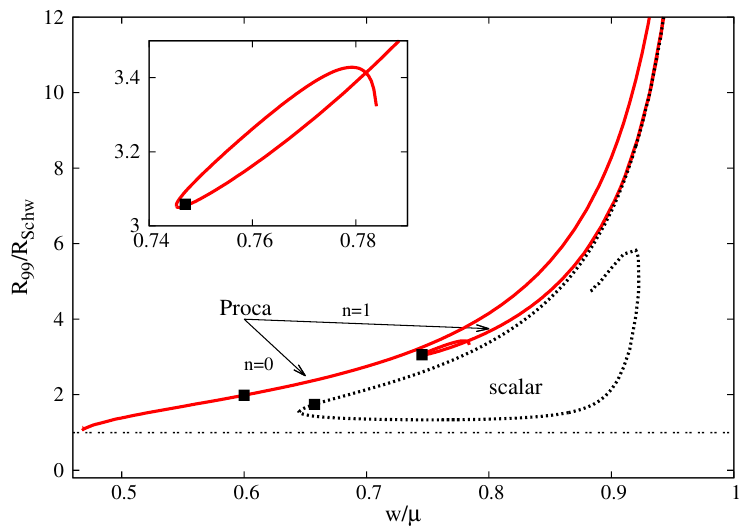
Figure 5 . Inverse compactness of the three families of solutions: n = 0 and n = 1 Proca stars (red solid lines) and n = 0 scalar boson stars (black dotted line), all with m = 1. The inset exhibits a detail of the n = 1 Proca stars line. The squares mark the (cid:12)rst occurrence of an ergo-region along the family of bosonic